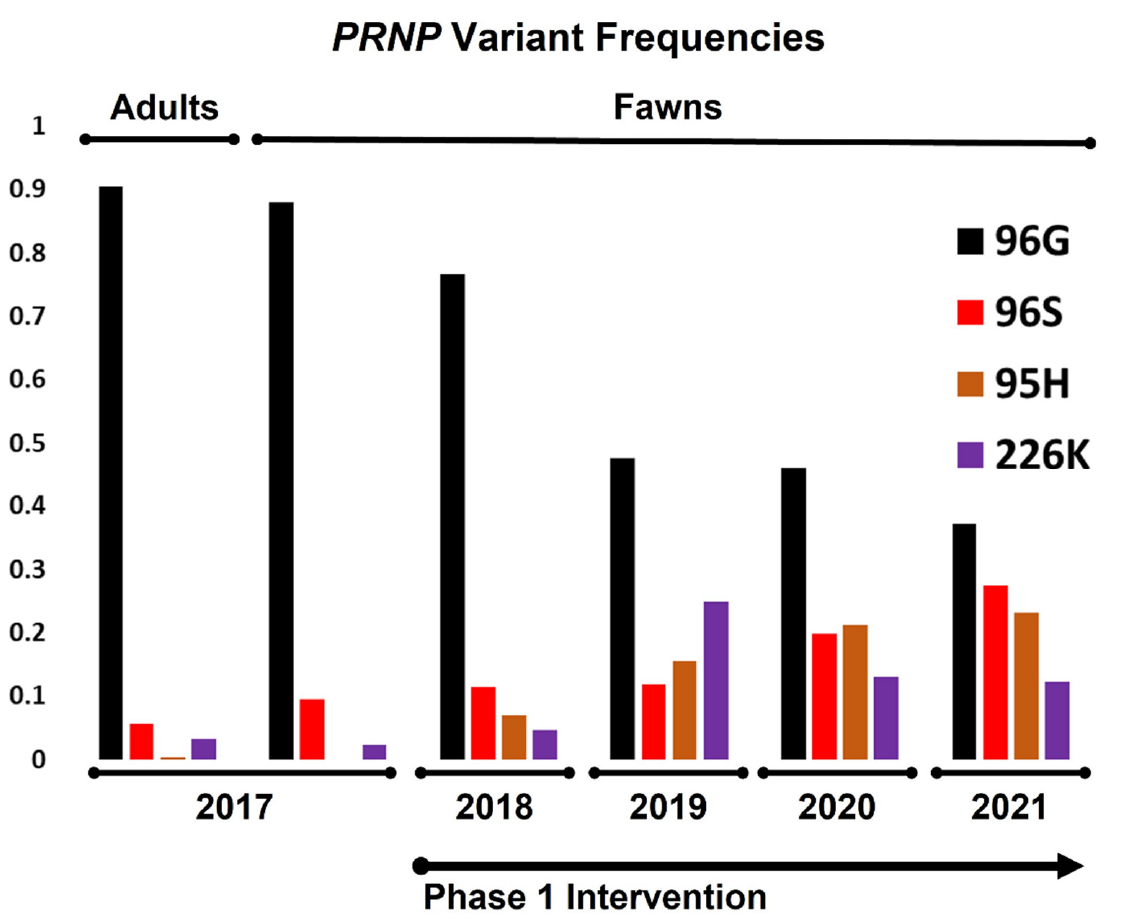
Figure 2. Changes in PRNP variant frequencies among breeding animals and fawns, both prior to and following selective breeding intervention. The frequency of 96G variants, e.g., the percentage of 96G variants (those variants without non-synonymous SNPs at other positions) among all chromosomes in the population, shifted markedly from a high of over 90% to less than 40% over the first phase of the project, with concurrent gains seen in 95H, 96S, and 226K variants.